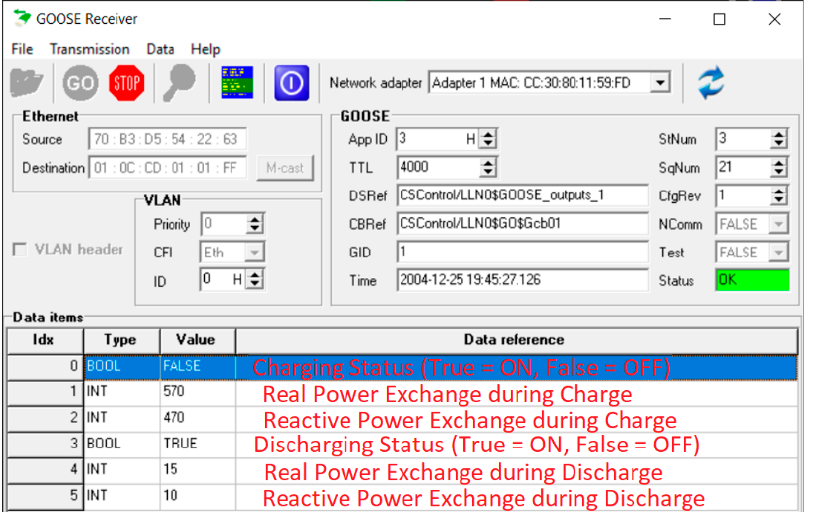
Figure 8. GOOSE message received by the EV, discharge command, P = 15, and Q = 10.